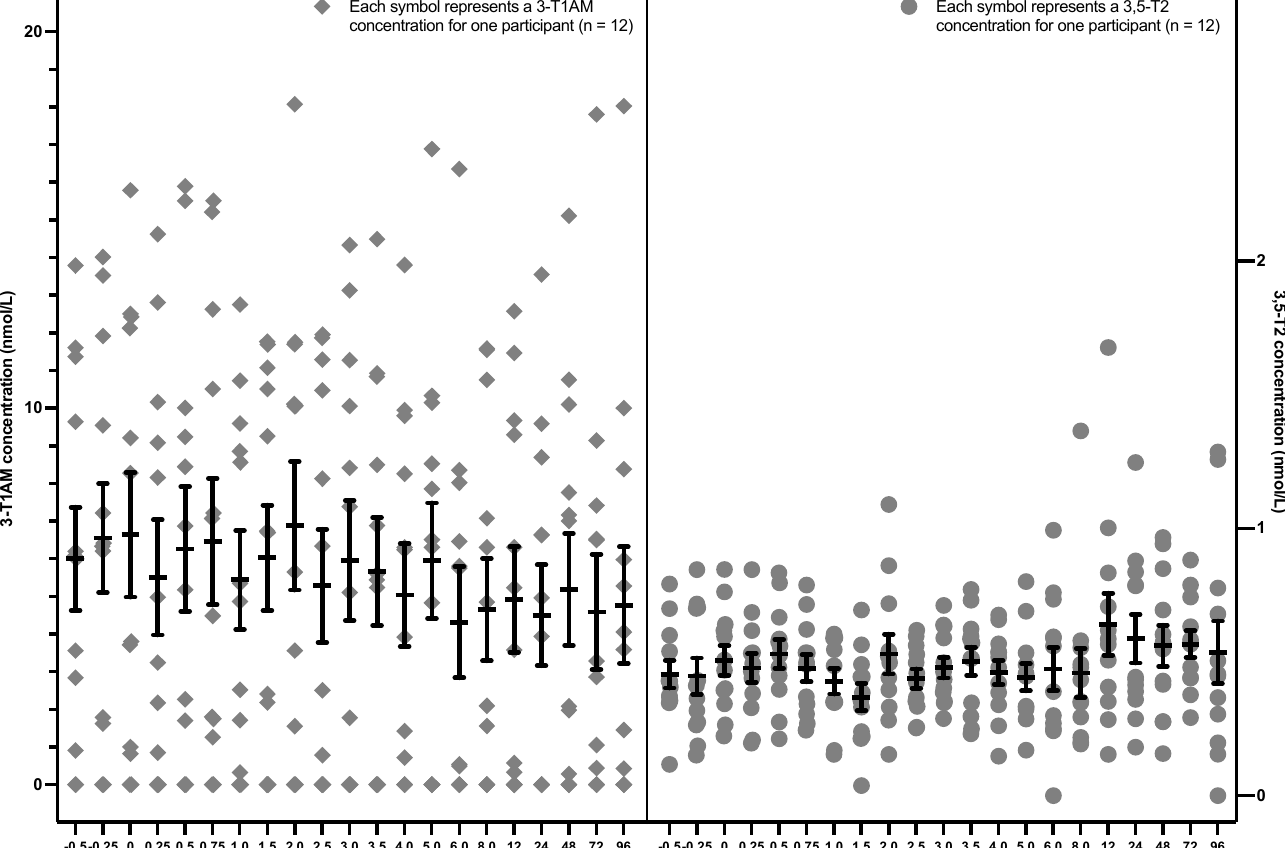
Figure 2. Hourly 3,5-T2 and 3-T1AM concentrations after a single 50 mcg dose of LT3 in 12 healthy volunteers (The lower limit of detection is 0.2 nmol/L for 3,5-T2 and approximately 5 nmol/L for 3-